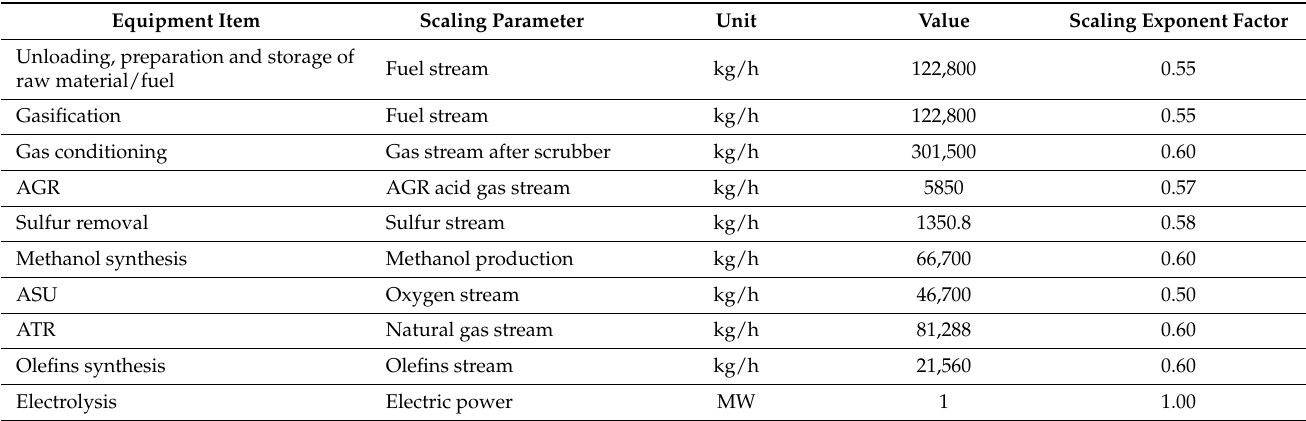
Table 6. Summary of basic data for expenditure on plant equipment.